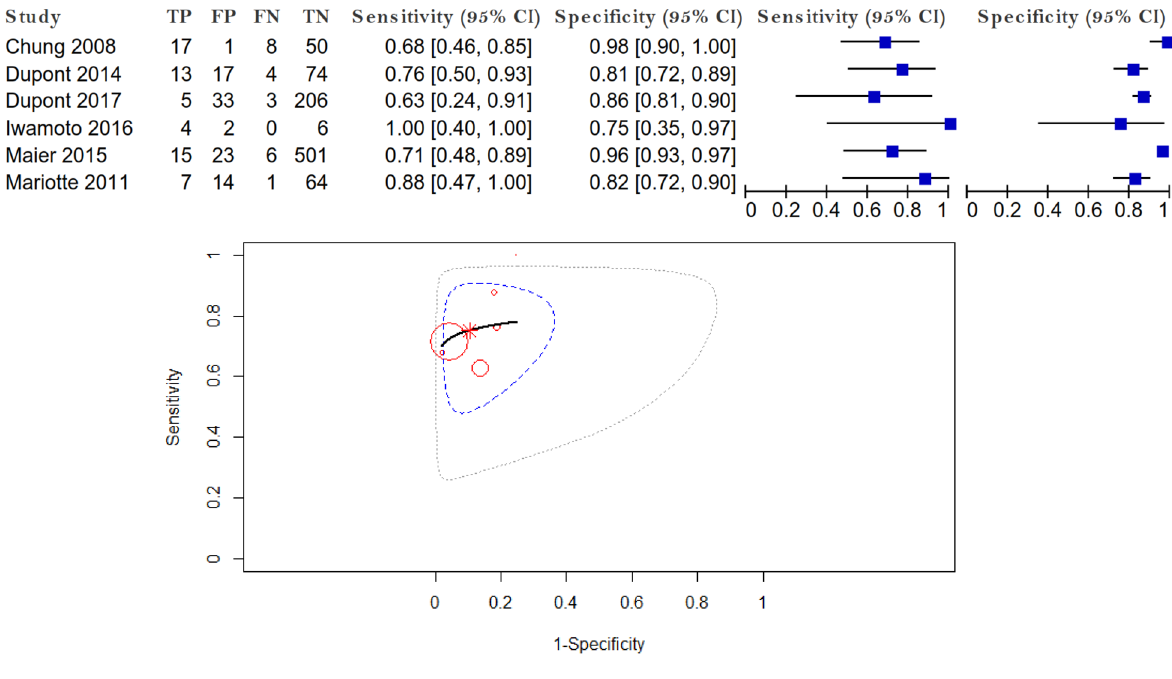
Figure 3. Forest plot and SROC